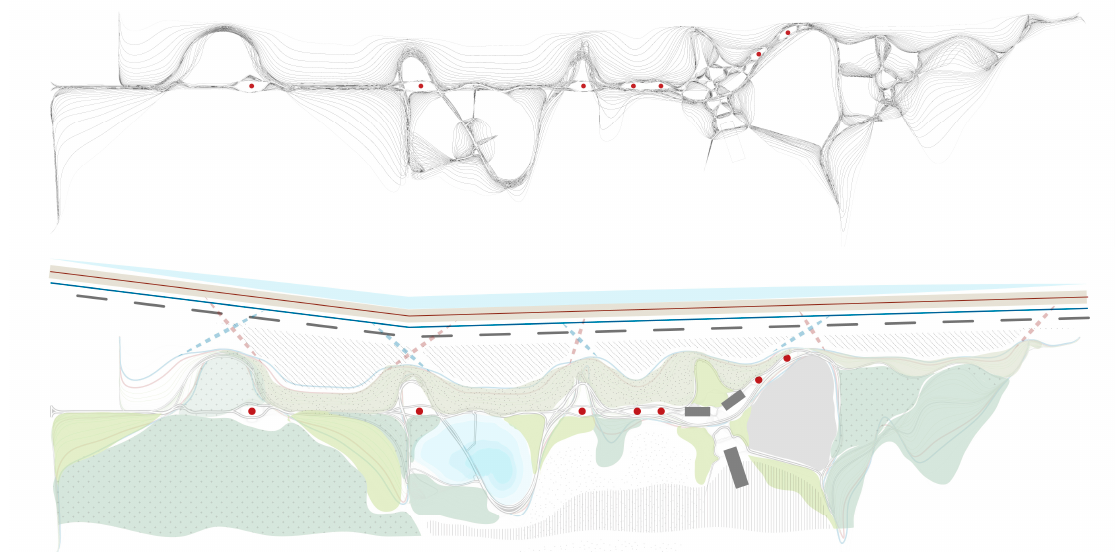
Figure 1. Final outcome of the stabilization process and final proposed layout for the project’